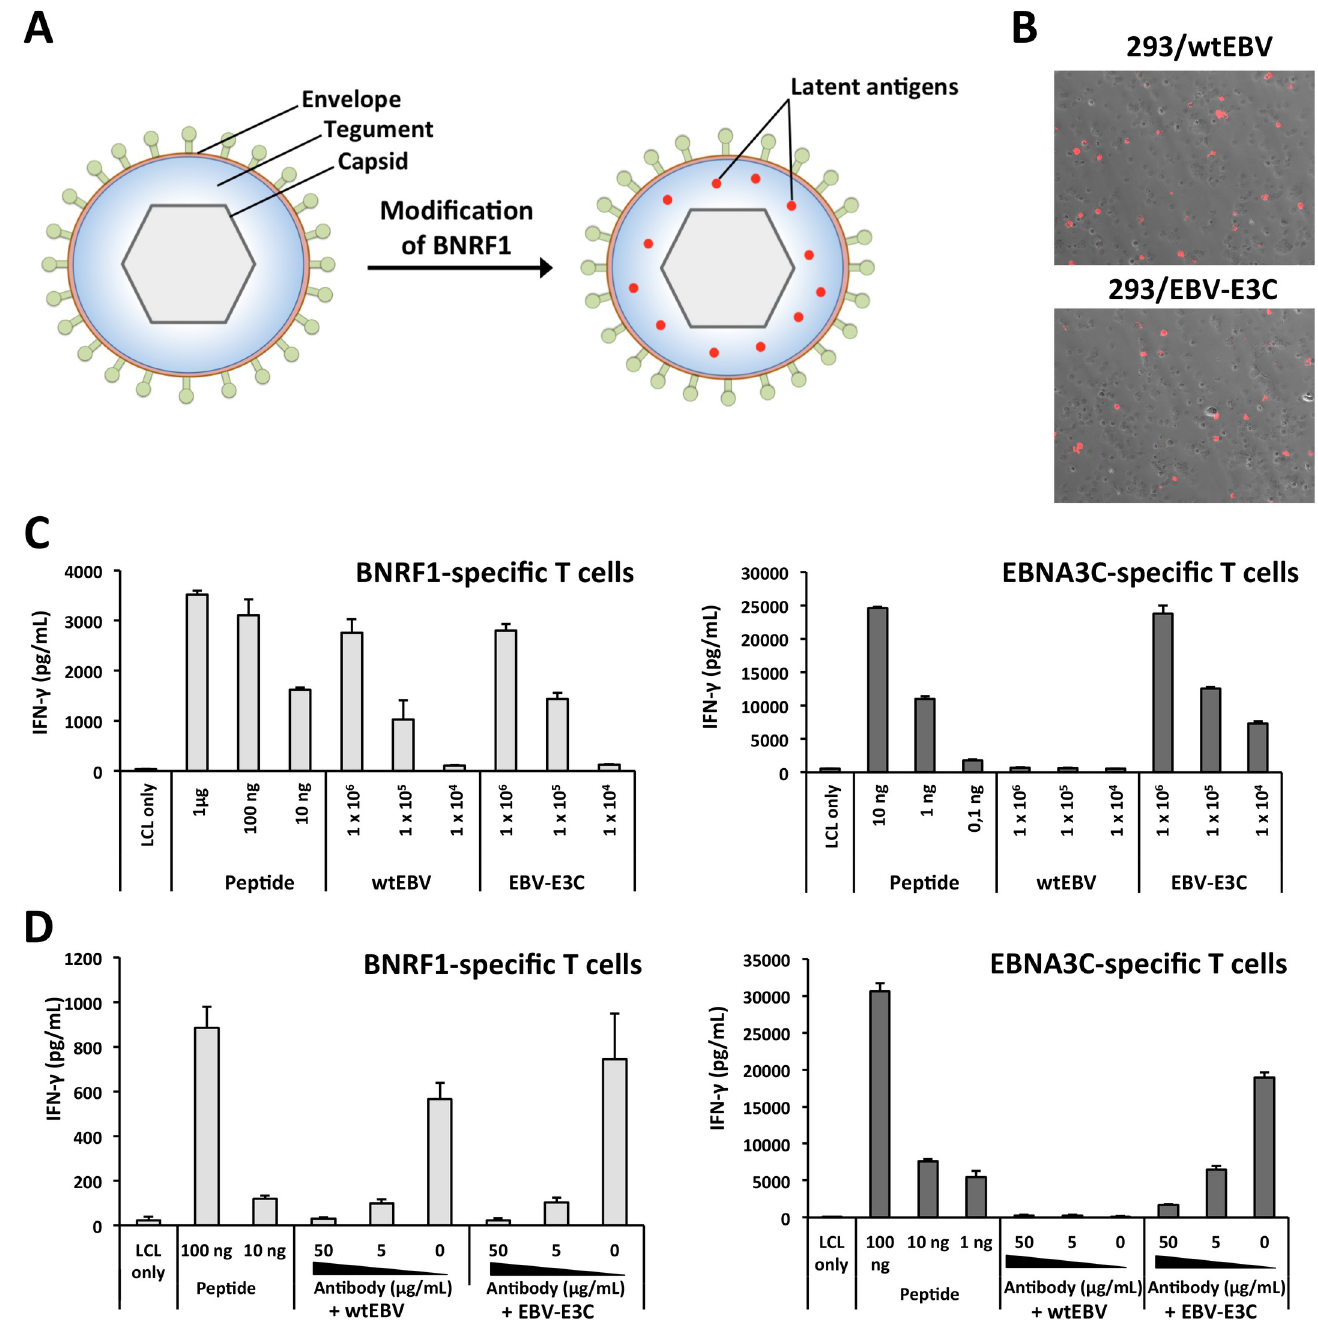
Fig 1. The antigenic spectrum of EBV virions is enlarged through the construction of BNRF1-latent protein gene fusions. (A) The insertion of latent protein epitopes into the major tegument protein BNRF1 enables them to be incorporated into the tegument of VLPs/LPs. (B) Modification of BNRF1 to include an antigenic fragment from EBNA3C (E3C) does not influence lytic replication in producer cells. The late lytic gene product gp350 was detected at the surface of induced 293/wtEBV and 293/EBV-E3C producer cells by staining with α -gp350 and α -mouse IgG-Cy3 antibodies. (C) EBV virions that encode a BNRF1-EBNA3C fusion protein stimulate BNRF1- and EBNA3C-specific CD4 + T cells. Autologous LCLs were pulsed with various amounts (1 x 10 4 to 1 x 10 6 genome equivalents (geq)) of wtEBV or EBV-E3C and then cocultured with CD4 + T cells that were specific for BNRF1 VSD (1006–1017 aa) or EBNA3C 5H11 (325–339 aa) epitopes. In parallel, LCLs were pulsed with control peptides ( μ g to ng quantities) prior to coculture with CD4 + T cells. T-cell activation was determined by measuring secreted IFN- γ by ELISA. (D) A neutralizing antibody that recognizes gp350 impairs the antigenicity of wtEBV and EBV-E3C. The neutralizing antibody 72A1 was titrated (50, 5 and 0 μ g/mL) and incubated with 1 x 10 6 geq of wtEBV and EBV-E3C. Thereafter, supernatants were used in T-cell activation assays. The data displayed in each chart represents triplicate values and error bars represent standard deviation. Furthermore, each graph is a representative experiment of at least three.